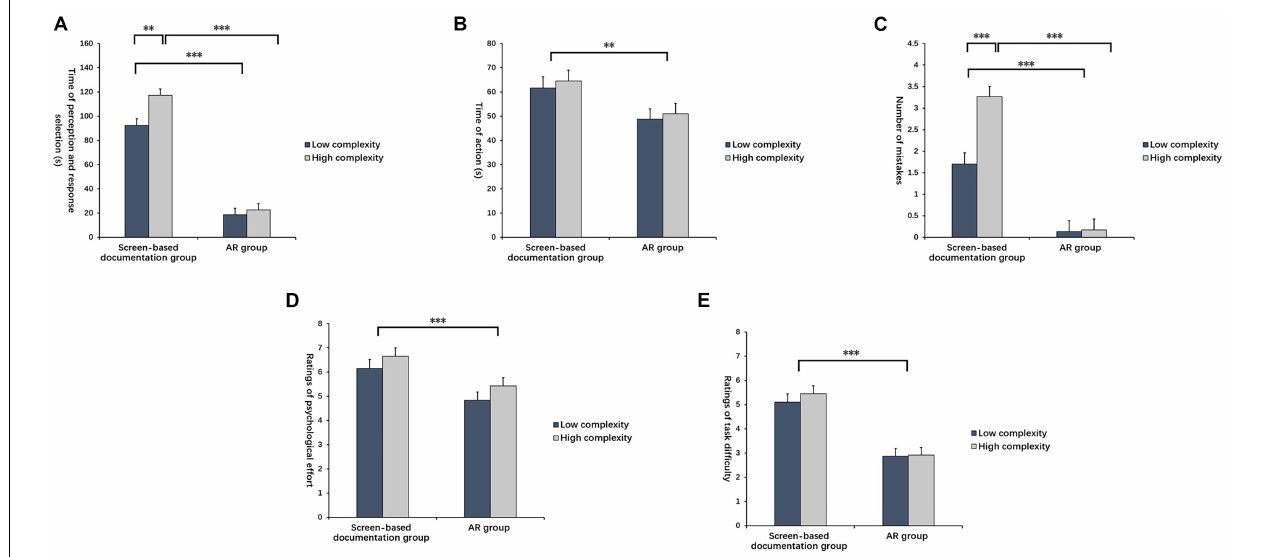
FIGURE 8 | Indexes in commissioning subtask with various complexities under two assistance modes. (A) Time of perception and response selection, (B) Time of action, (C) Number of mistakes, (D) Ratings of psychological effort, and (E) Ratings of task difficulty. ∗∗ Indicates p < 0.01; ∗∗∗ indicates p <